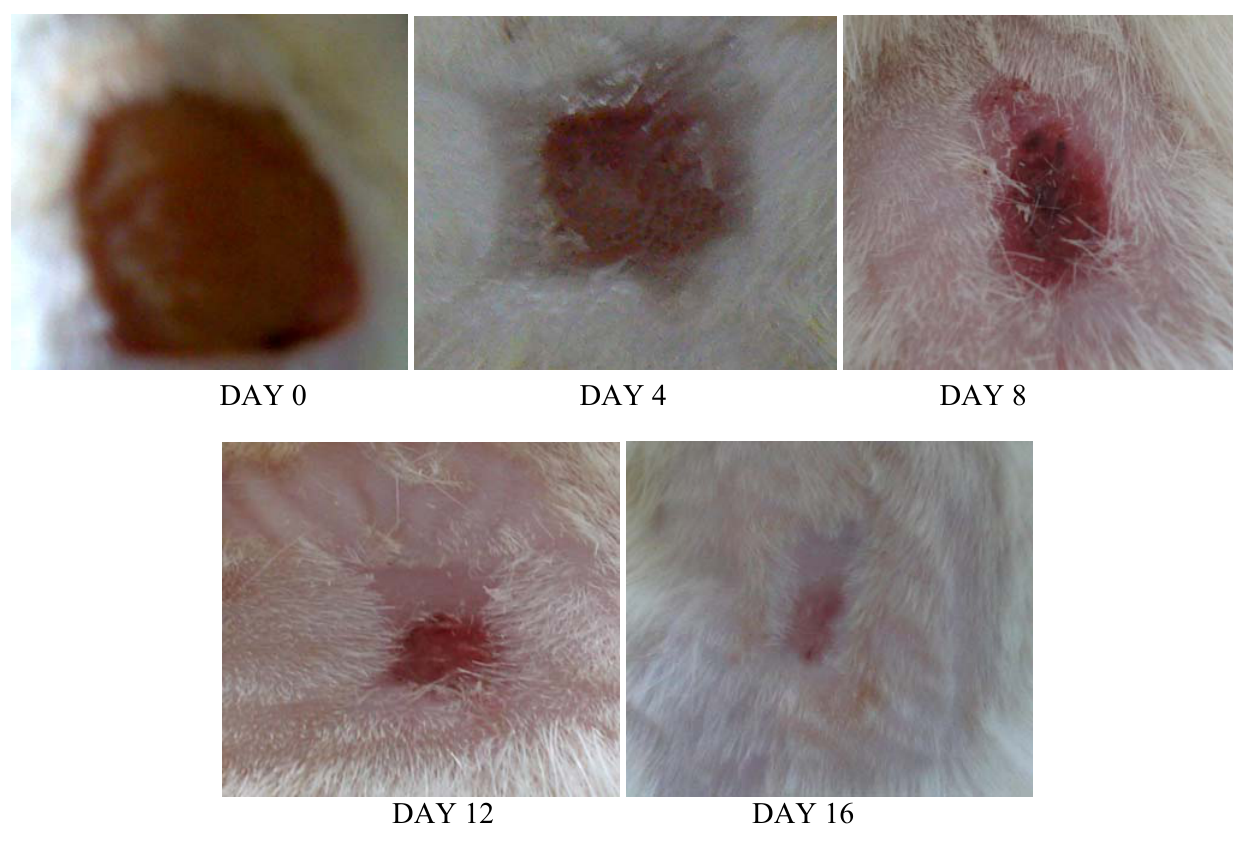
Figure 3. Photographical representation of contraction rate on different days in treatment